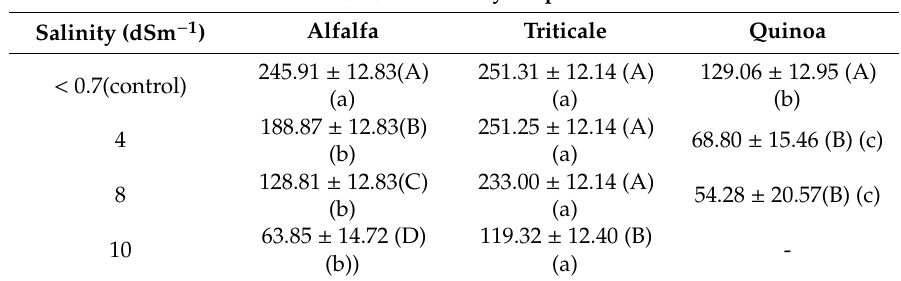
Table 8. Timson’s Index (TI) for salinity × species interaction for alfalfa, triticale, and quinoa at four di ff erent